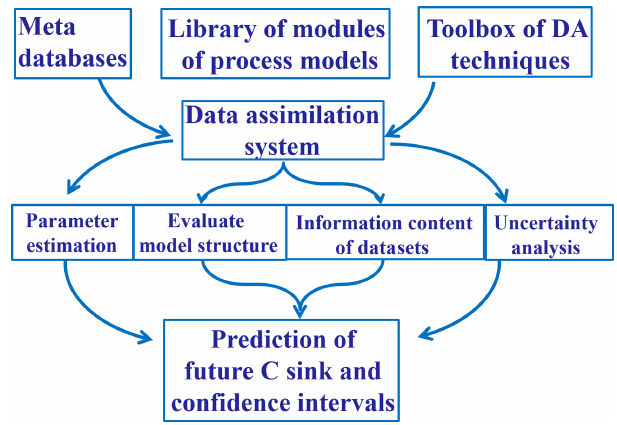
Figure 2. The data assimilation system inside the Ecological Plat- form for Assimilation of Data (EcoPAD, v1.0) towards better fore- casting of terrestrial carbon